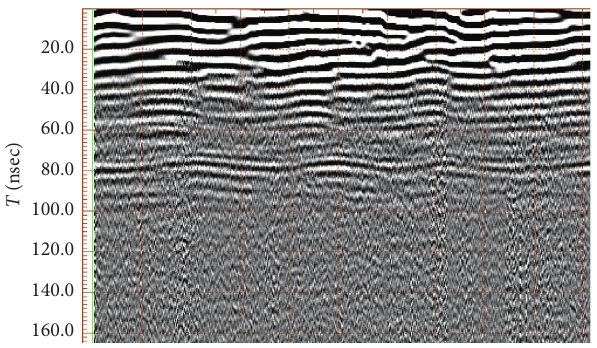
Figure 12: Radar image after the linear gain operation.